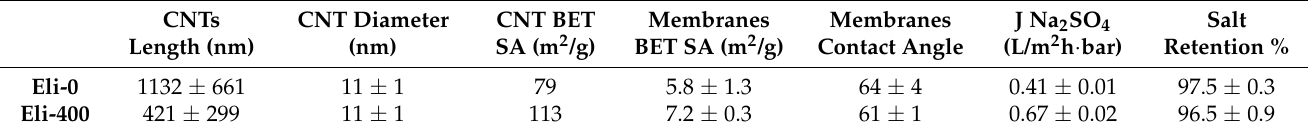
Table 4. Summary of all